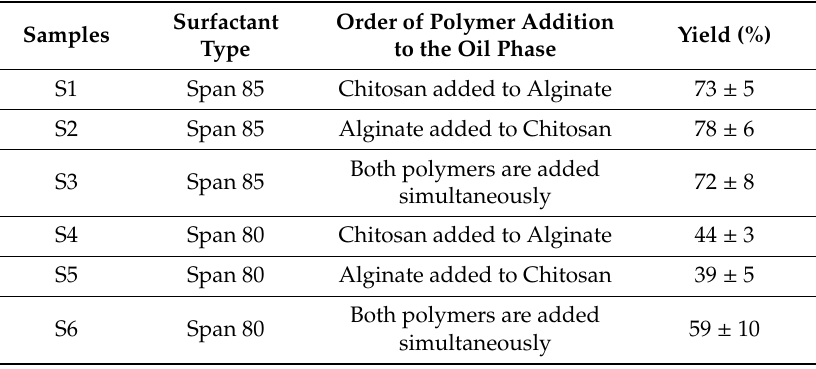
Table 1. Samples IDs and preparation conditions used in this